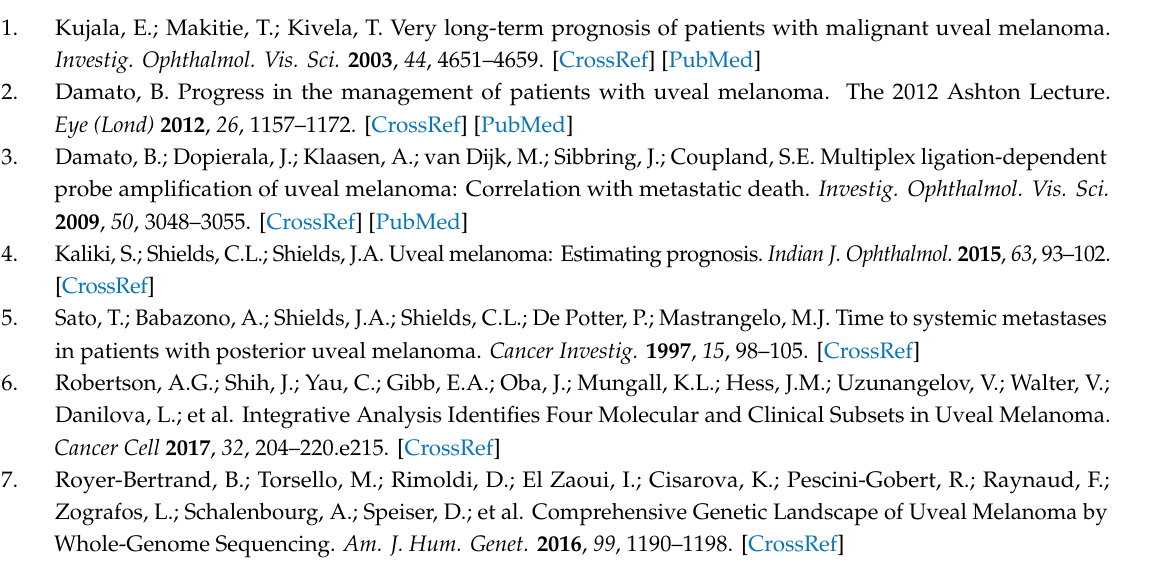
Figure S1: Heatmap highlighting the relative expression of gene markers for M2 TAMs in mUM versus control; Figure S2: Heatmaps showing relative gene expression within mUM versus control for: (A) cancer-testis antigens and (B) immune checkpoint inhibitors; Figure S3: Venn diagrams showing the list of genes used for immune cell type profiling (A) and cell function profiling (B); Figure S4: Increasing stages of fibrosis, and necrosis; Figure S5: Macroslide image of a hepatic mUM demonstrating how cores were taken for intratumoural heterogeneity analysis. Table S1: Clinical and histomorphological information for all the hepatic mUM samples; Table S2: NanoString di ff erential expression output data for mUM for: (A) Total immunoscore, (B) TAMs immunoscore, (C) TILs “altered versus absent,” and (D) TILs “high versus absent;” Table S3: NanoString di ff erential expression output data for mUM for: (A) all mUM versus control liver and (B) nBAP1 status in mUM; Table S4: Summary of IHC results; Table S5: Details of the antibodies used for